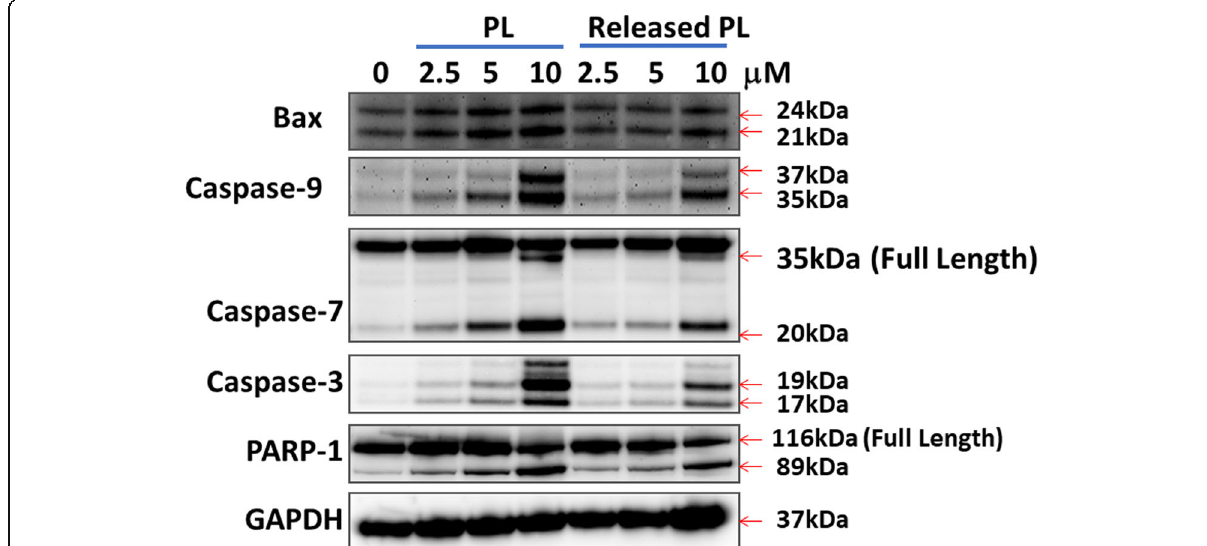
Fig. 6 Western blot analysis of apoptosis of HuCC-T1 cells. Cells were treated PL itself or released PL from nanofibers for 1 day and then performed western blot